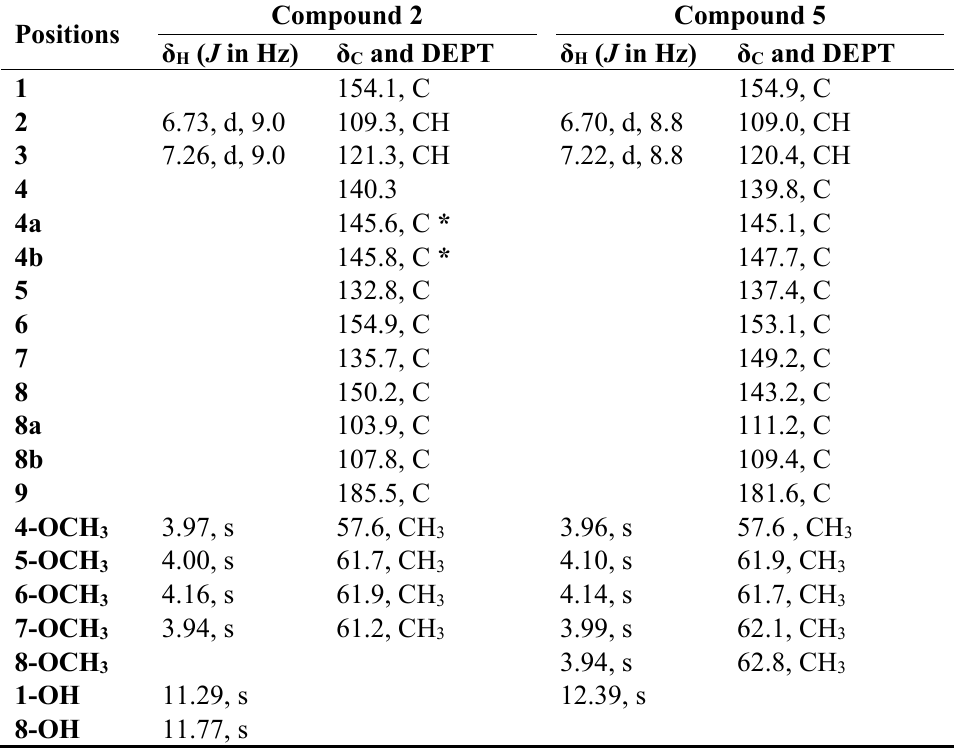
Table 1. 1 H-NMR (300 MHz) and 13 C-NMR (75 MHz) spectral data for compounds 2 and 5 in CDCl 3